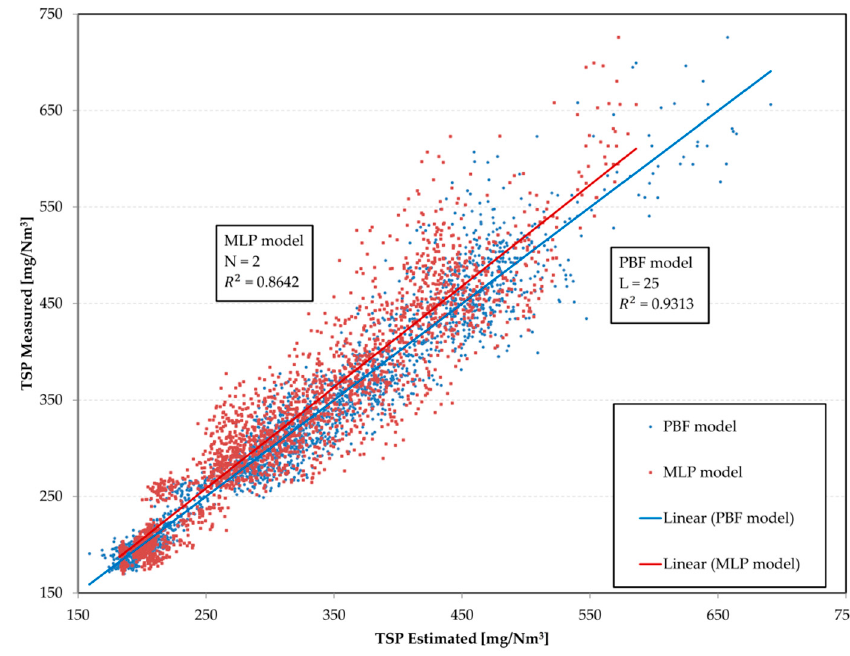
Figure 8. TSP emission models performance.